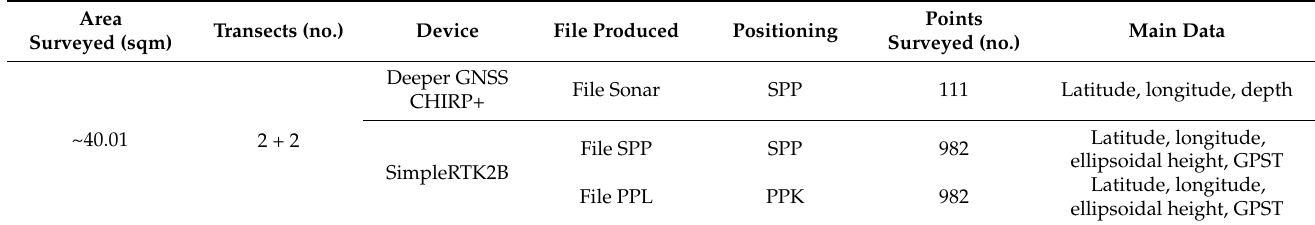
Figure 3. ( a ) Survey area at sea; ( b ) preparation of instruments; ( c ) floating platform; ( d ) preparation of SUP for the survey; ( e ) floating platform connected to SUP; ( f ) survey at sea.